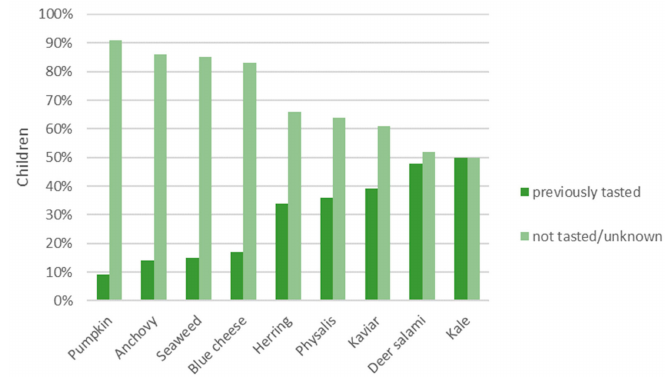
Figure 1. Familiarity of food stimuli from the least previously tasted and most unknown (left) to the most tasted food stimuli (right); n = 201–205